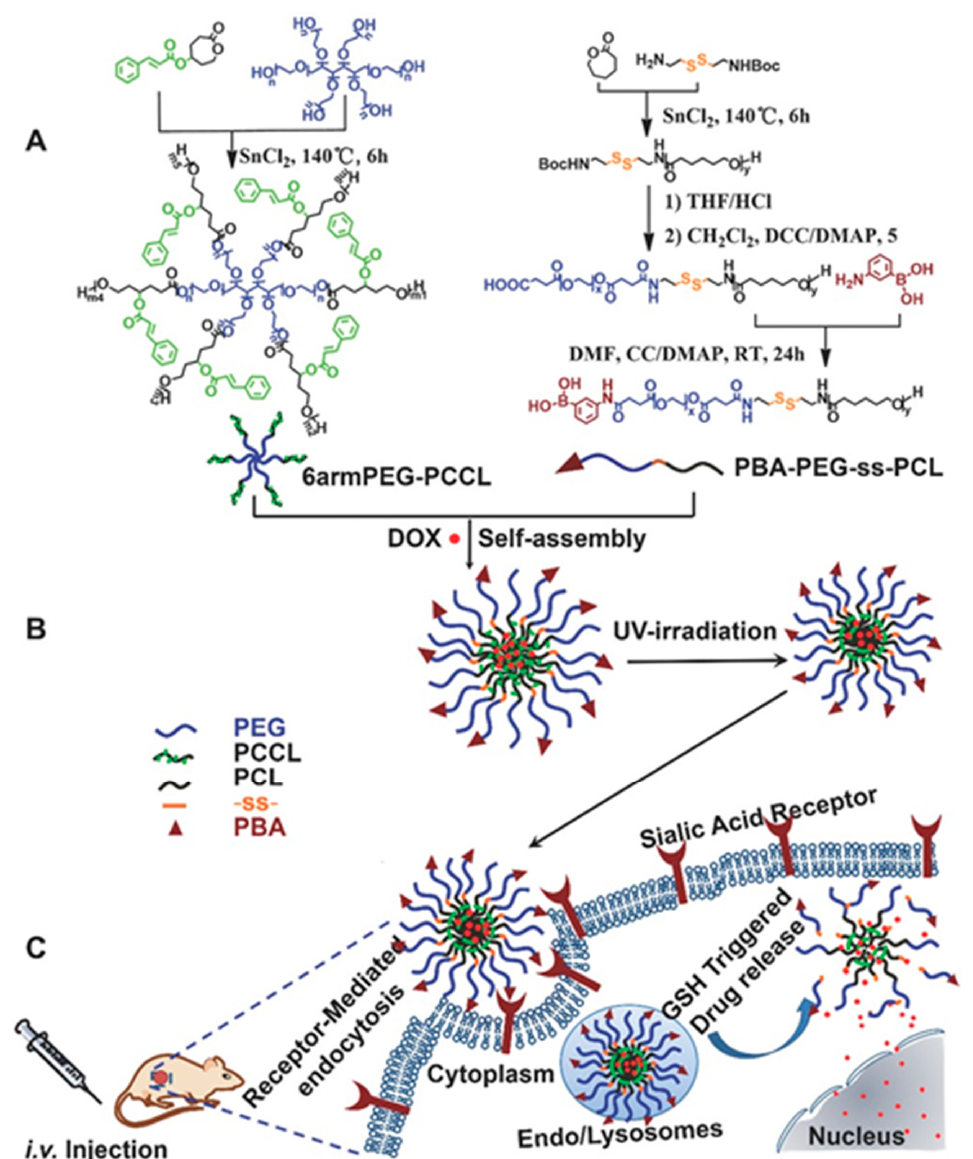
Figure 7. ( A ) Synthetic route and chemical structure of 6arm PEG-PCCL and PBA-PEG-ss-PCL copolymers. ( B ) Schematic illustration of DOX-loaded star-shaped mixed micelle formation and photo-crosslinking under 365 nm UV light irradiation. ( C ) Phenylboronic acid-mediated endocytosis of these multifunctional micelles and subsequently GSH-triggered intracellular drug release. Reproduced with permission from Qu, Q.; Wang, Y.; Zhang, L.; Zhang, X.; Zhou, S. A nanoplatform with precise control over release of cargo for enhanced cancer therapy. Small 2016 [164].